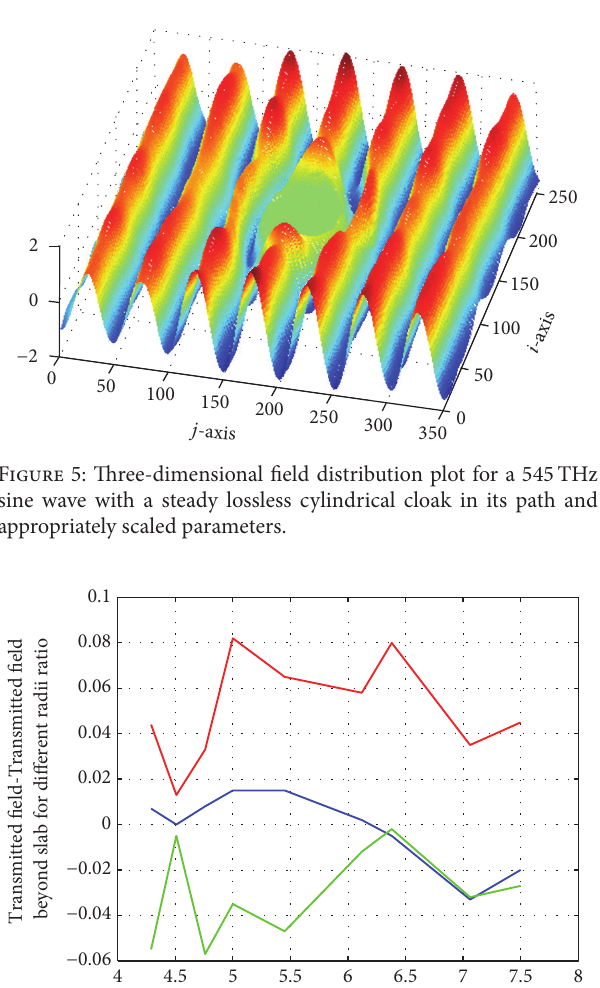
Figure 4: Three-dimensional field distribution plot for a 2 GHz sine wave with a steady lossless cylindrical cloak in its path.